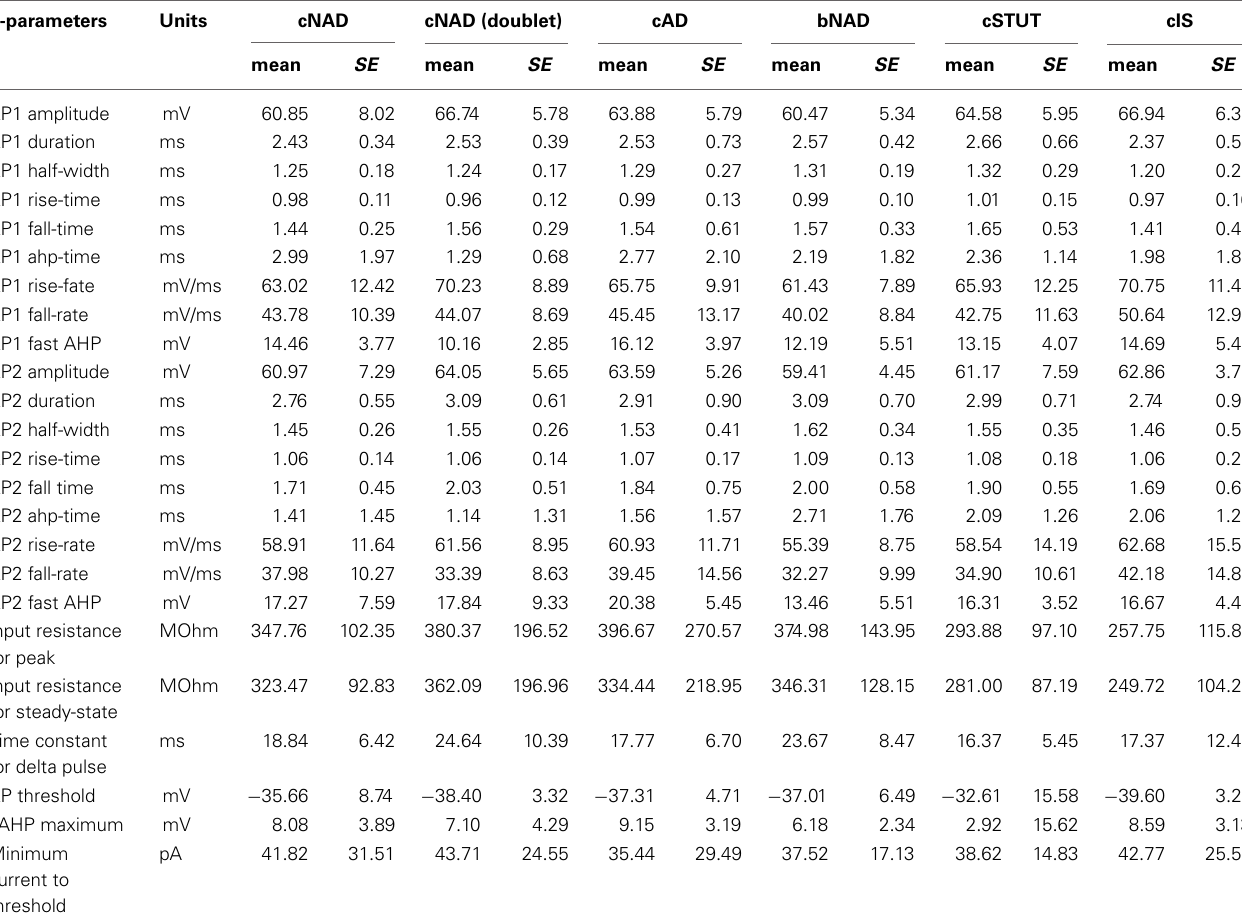
Table 3 | Summary of the electrophysiological parameters of each of the firing pattern cell-types in L1.